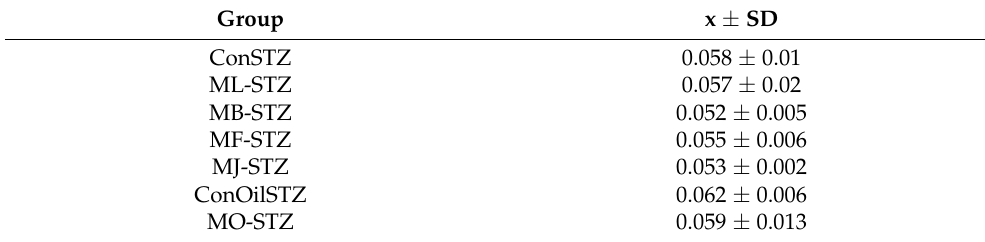
Table 5. Hepatosomatic index in mice with streptozotocin-induced oxidative stress (ConSTZ—saline 10 mL/kg; ConSTZOil—olive oil 10 mL/kg; ML-STZ—black mulberry leaf ethanol